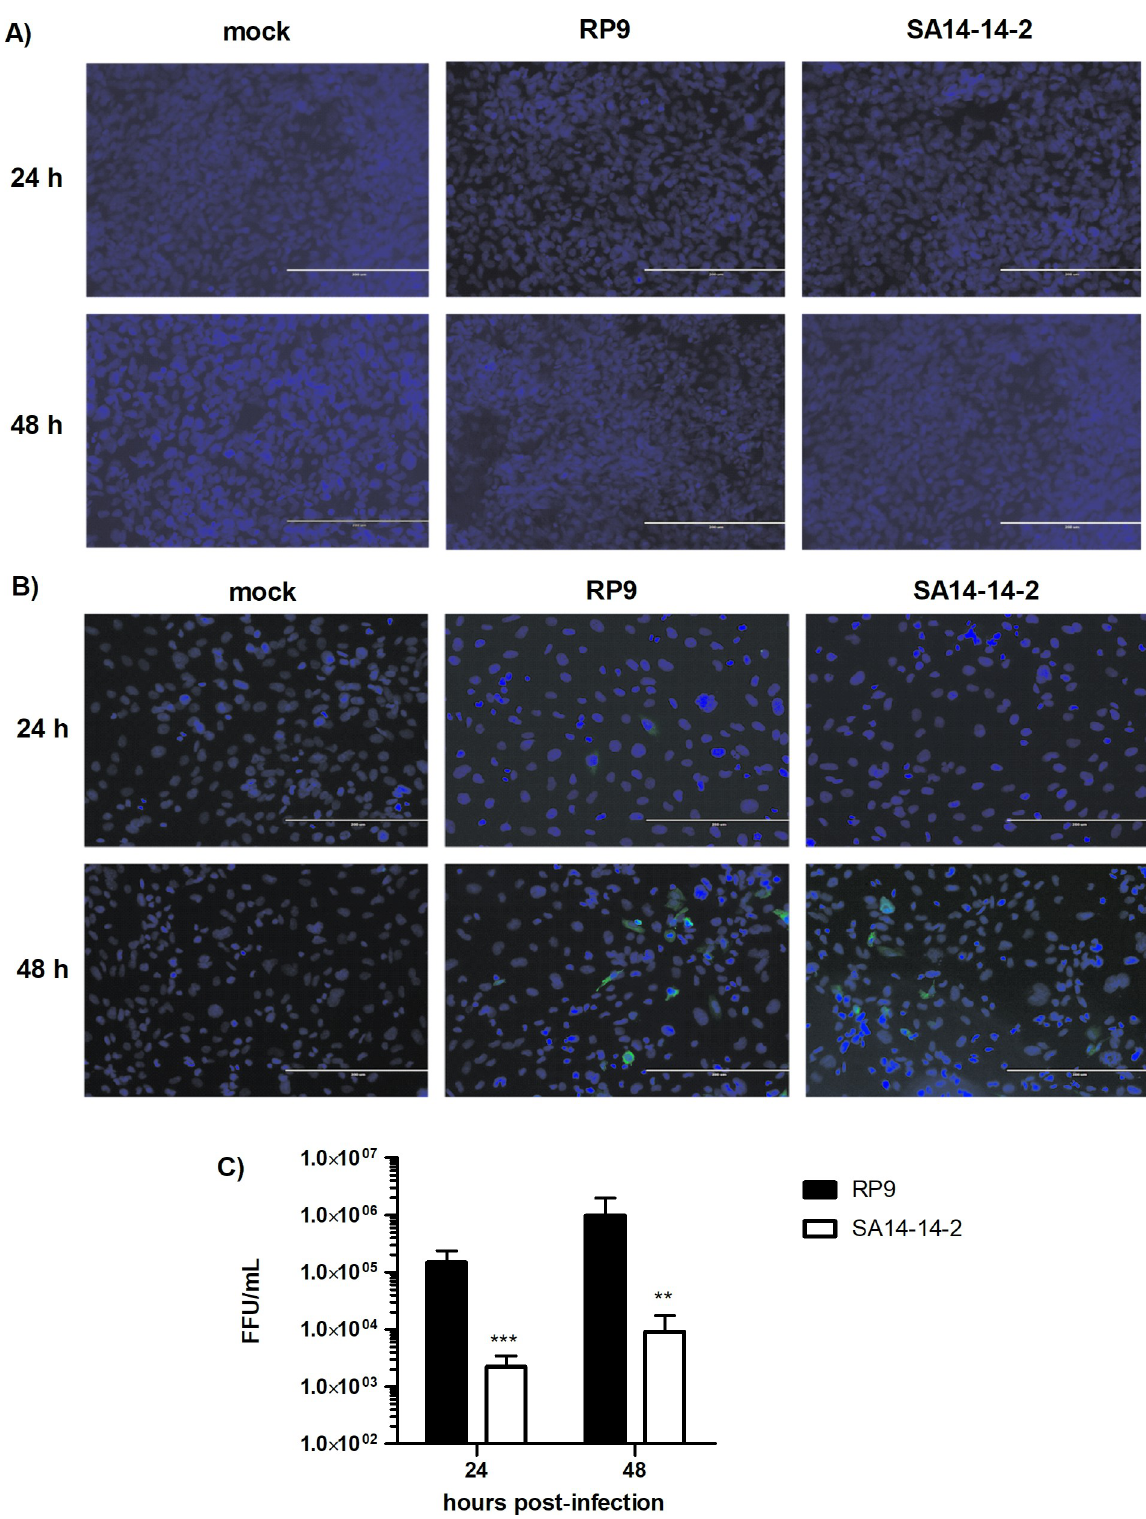
Fig 3. Infection of hCMEC/D3 cells by JEV strains. hCMEC/D3 were cultured on coverslips for either 6 days ( A ) or 1 day ( B ), so that they form or do not form a BBB respectively. Cells were then inoculated with the indicated JEV strain at MOI = 0.1 and analyzed at 24 and 48 hpi by immunofluorescence staining for the presence of the NS5 protein (in green). The images were taken at a x200 magnification, cells nuclei are